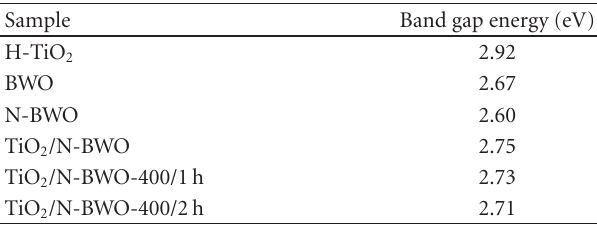
and its ultraviolet absorption is weak. In comparison with Table 4: Estimation of the band gap energy of the as-prepared